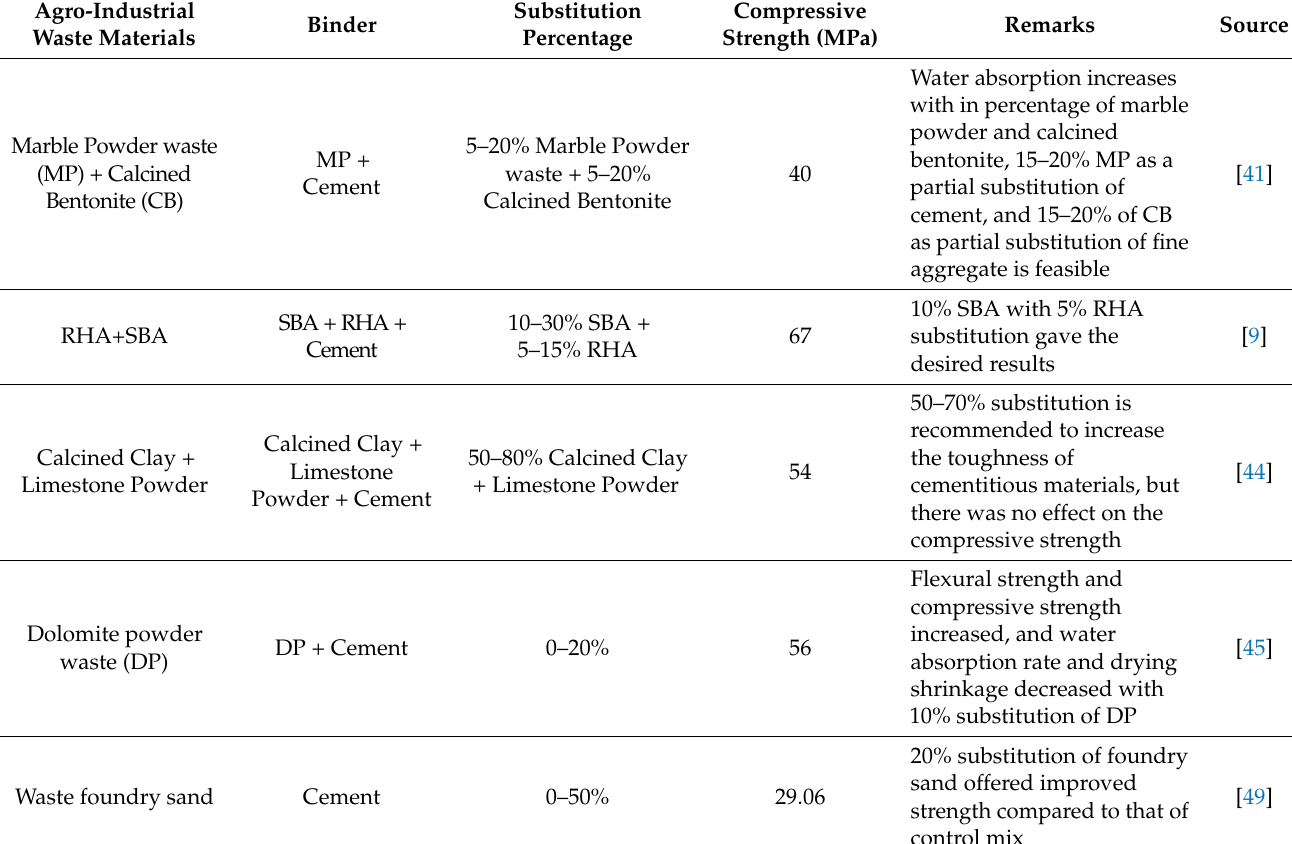
Table 1. Supplementary cementitious materials used in